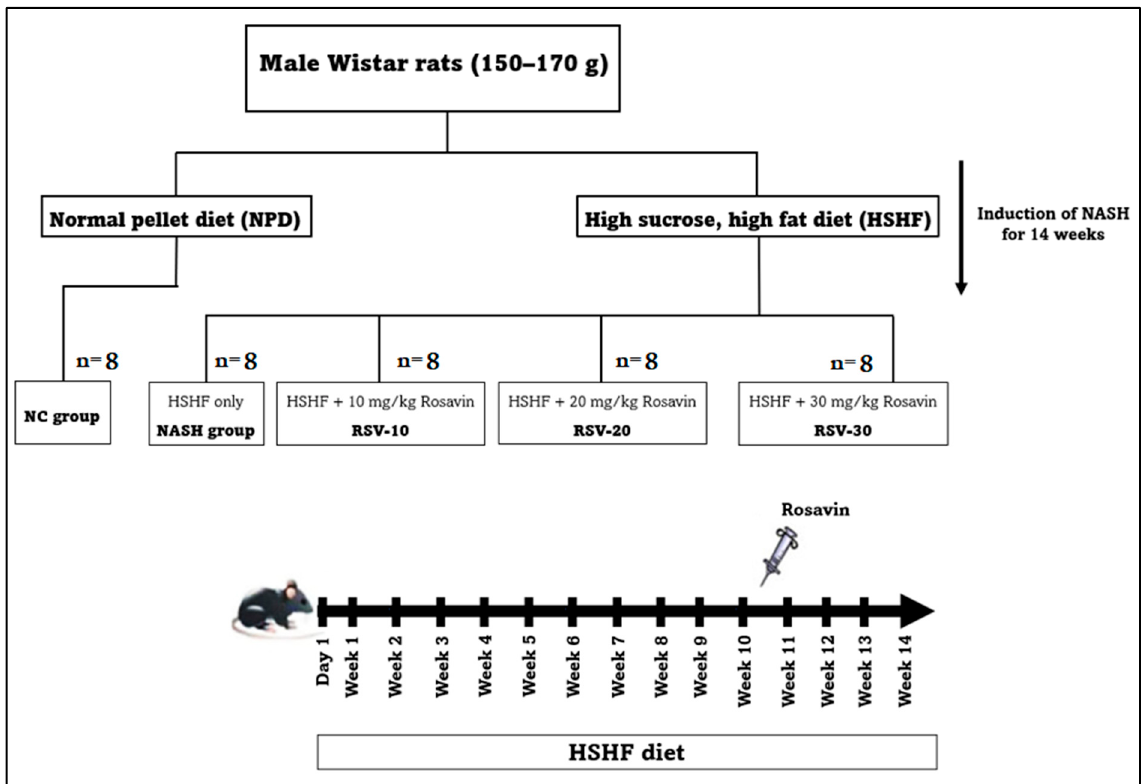
Figure 7. Schematic illustration of study design and the timeline for the animal experiment.